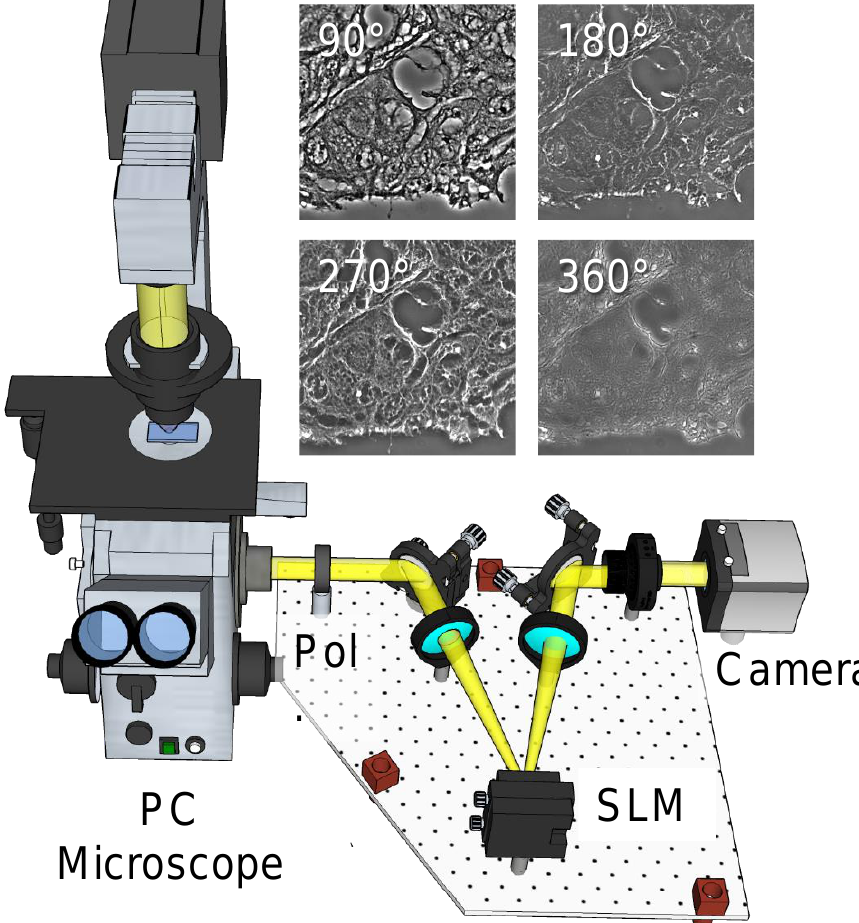
Figure 1. The SLIM tissue scanner setup. The SLIM system was implemented as add-on to an existing phase contrast microscope. Pol, polarizer; SLM, spatial light modulator. The four independent frames corresponding to the four phase shifts imparted by the SLM are shown for a tissue sample.